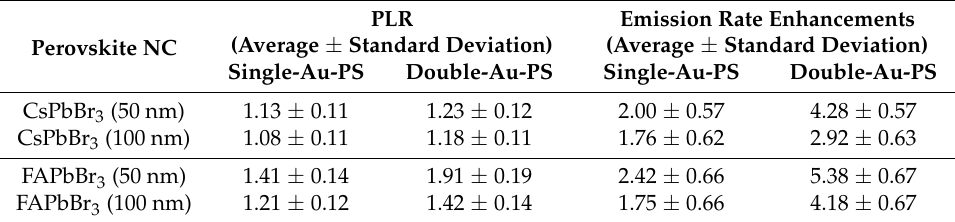
Figure 3. Time-resolved (TRPL) emission measurements. Decay curves of reference (black), single- Au-PS- (red), and double-Au-PS-NC samples (blue) measured for ( a ) 50 and ( b ) 100 nm thick CsPbBr 3 NCs and ( c ) 50 and ( d ) 100 nm thick FAPbBr 3 NCs. We monitor 505 and 545 nm emission for measurements of CsPbBr 3 and FAPbBr 3 NCs, respectively. Table 1. PL intensity ratios (PLR) and emission rate enhancements in single- and double-Au-PS-NC samples.